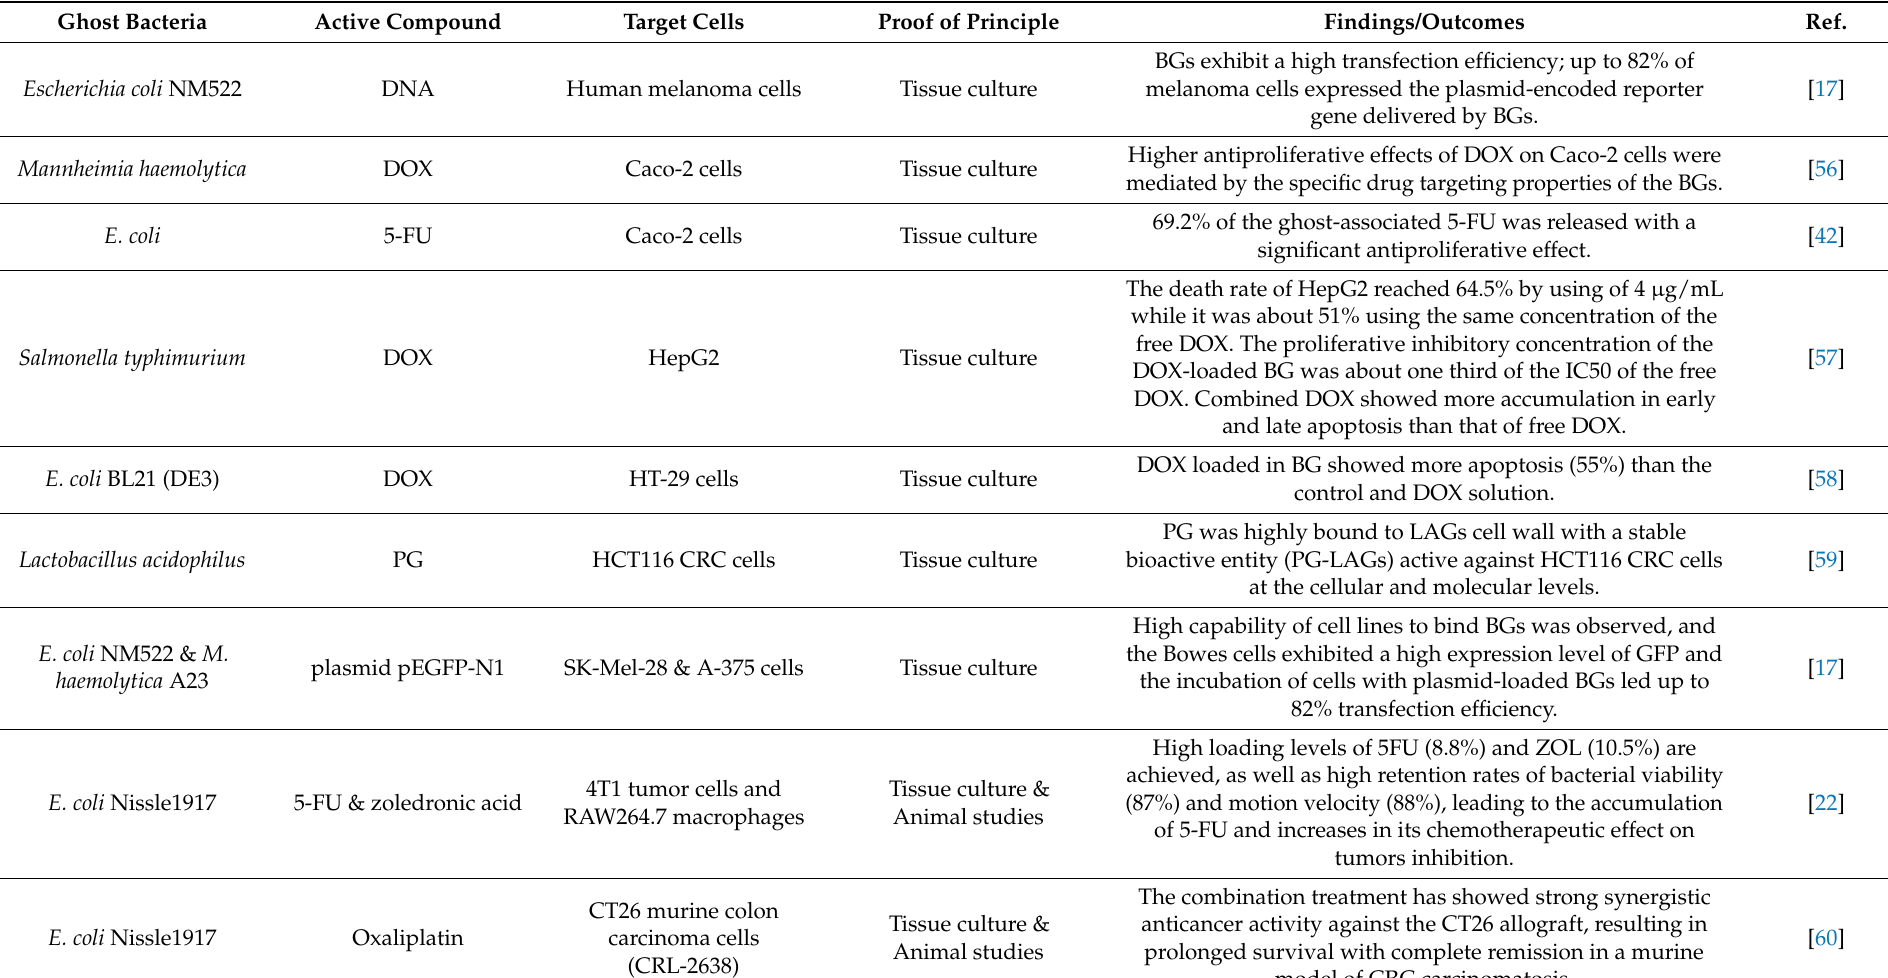
Table 2. Examples of BGs as delivery system and biological carrier for recent experimental anticancer